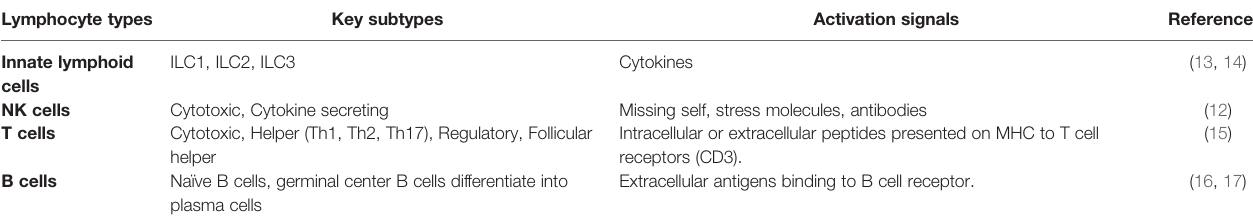
TABLE 1 | Overview of airway lymphocyte